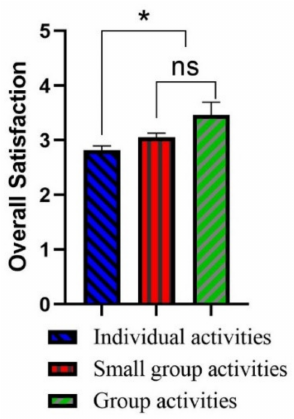
Figure 1. The impact of different activities on satisfaction. * Significant at p < 0.05. ‘ns’ indicates no significant difference.